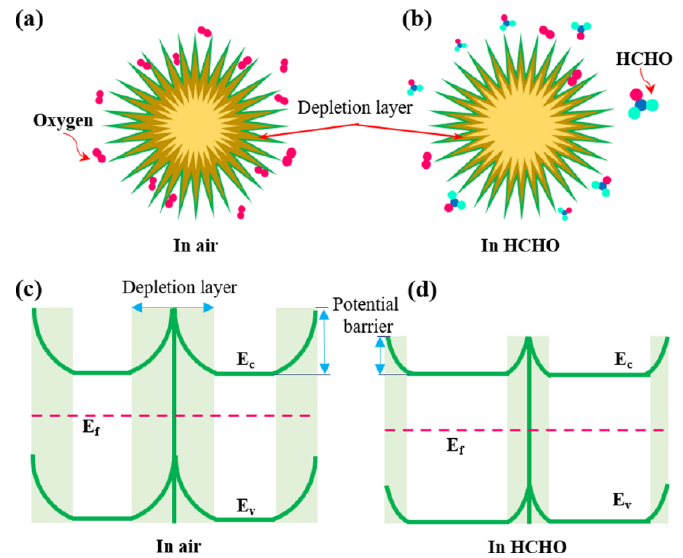
Figure 7. The long-term stability of three SnO 2 -based gas sensors towards 50 ppm HCHO at 275 °C.